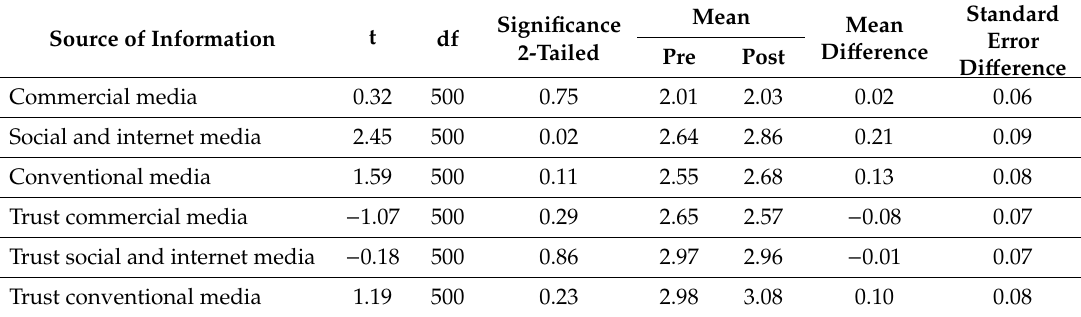
Table 7. Independent t tests comparing the perceived sources of information and the trust of information sources of respondents pre and post the 60 Minutes programme (based on composite